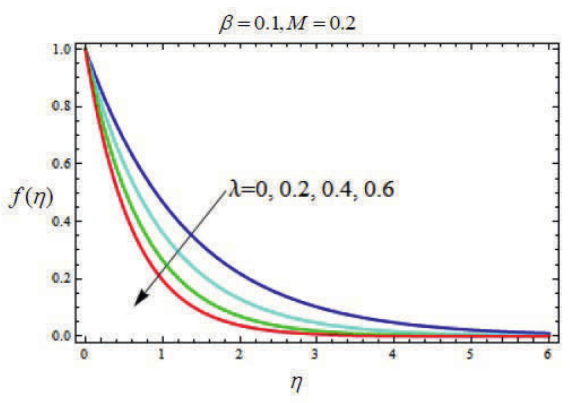
Table 2: Numerical values of the skin friction coefficient − f (cid:3)(cid:3) (0) for various values of β , λ and M .